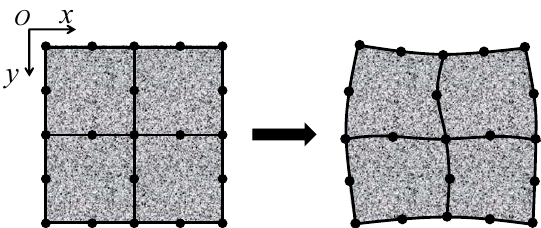
Figure 4. Original and deformed meshes in 8-node quadrilateral elements (Q8-DIC). An 8-node isoparametric quadrangular element in the global coordinate system xoy can be mapped onto a square in the local coordinate system o ξ η (Figure 5). The relationship between the two coordinate systems is expressed as follows: